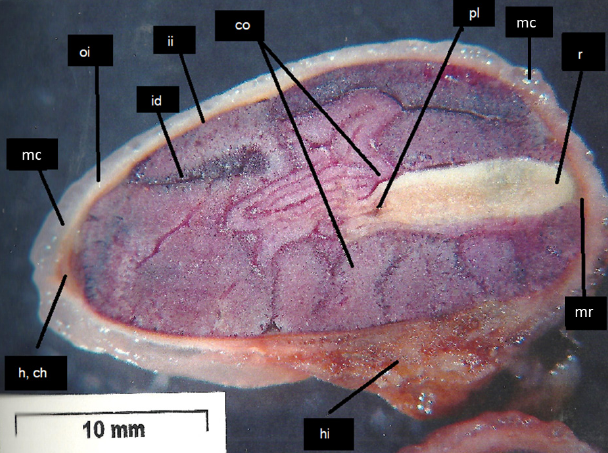
Fig. 3: Light microscope picture of the testa from depulped seed with muci- lage caverns, vascular bundles and blue colored polyphenol storage cells (this slice has been stained with Toluidine Blue O), oe = outer epidermis, mc = mucilage, pa = parenchyma (in this case, loosely stained parenchyma), vb, phloem = vascular bundles, phloem tissue, vb, xylem = vascular bundles, xylem tissue, ie = inner epidermis, lrw = embedding medium (LR-White Medium Grade). The limits of the exo (ex) and endotesta (en) are seen by a sclereid layer (sl). Neither the cotyledons nor the fruit pulp are to be seen in this testa prepara- tion. The non-cellular silvery layer is adjacent to the inner epider- mis but is not seen due to the preparation method of the testa. The magnification is indicated in the right upper corner and indicates 200